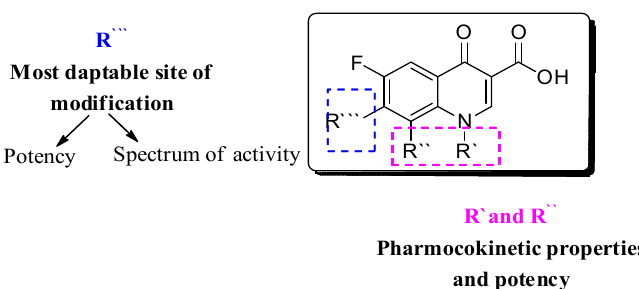
Figure 1. Fluoroquinolone’s nucleus: 1-substituted 1,4-dihydro-4-oxo-pyridine-3-carboxylic acid;